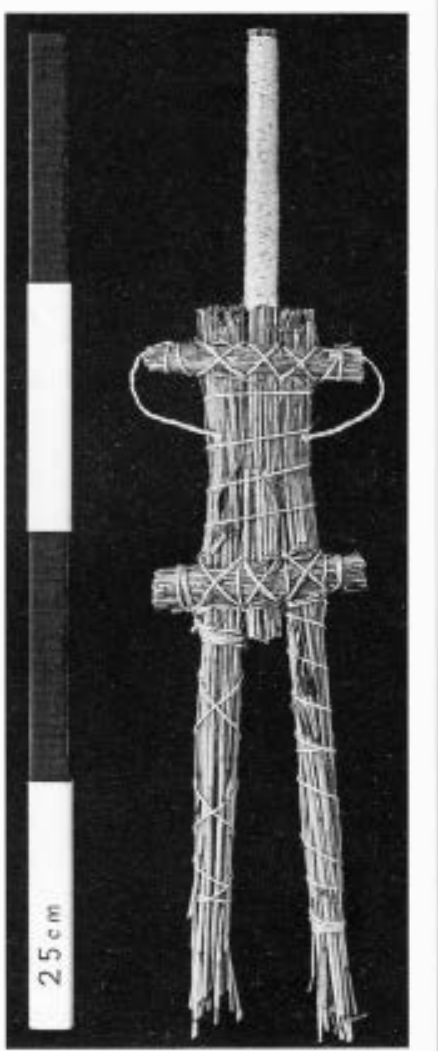
Figure 3 The crate containing the cache of statues suspended from the telescopic crane used to lift it up to the sixth floor of the Institute of Archaeology, London.